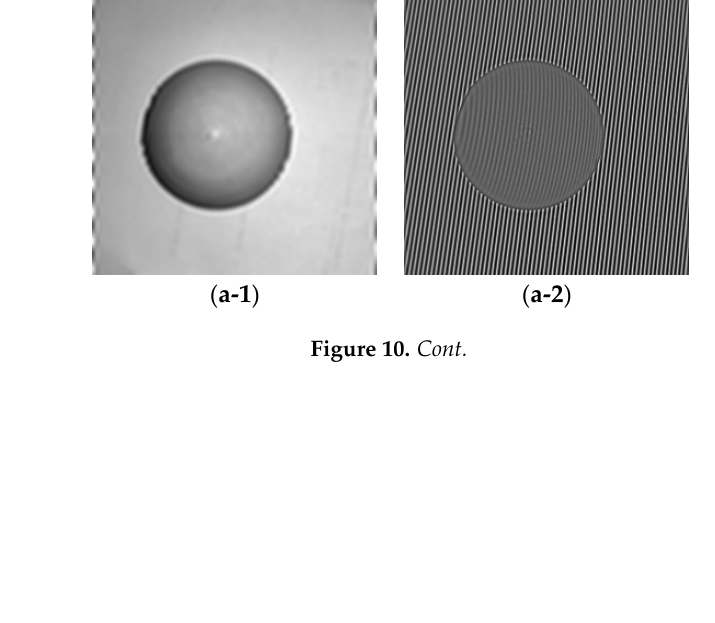
Figure 9. CrossUV, SE and SSIMV for Figure 3 by Fourier transform method with different parameter values. ( a-1 ) CrossUV for Figure 3a; ( a-2 ) SE for Figure 3a; ( a-3 ) SSIMV for Figure 3a; ( b-1 ) CrossUV for Figure 3b; ( b-2 ) SE for Figure 3b; ( b-3 ) SSIMV for Figure 3b.